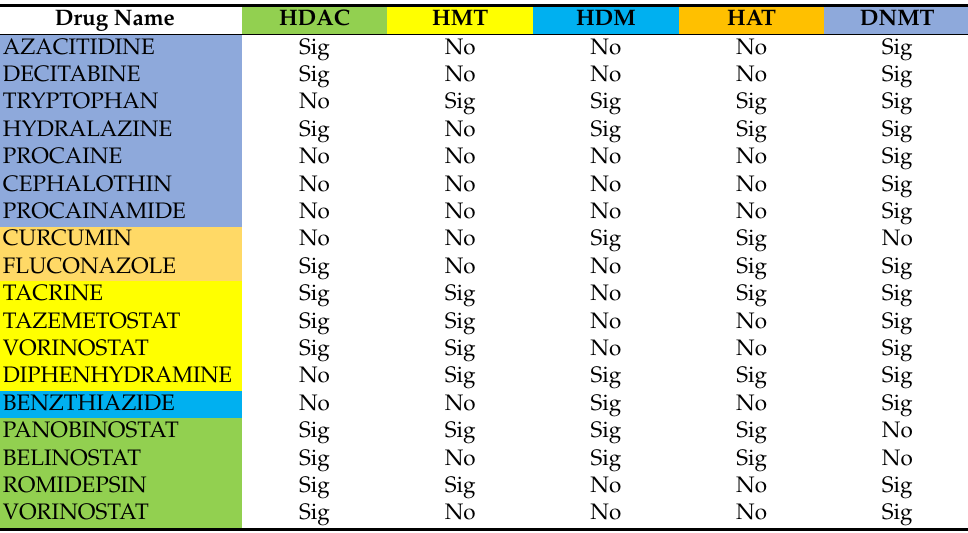
Table 3. Retrospective prediction of known drugs with their known targets. Different colors represent different epigenetic objects: Blue: DNMT, orange: HAT, yellow: HMT, light blue: HAT, green: HDAC. Sig indicates statistical significance in the Hypergeometric test for all targets in each object ( p -value <